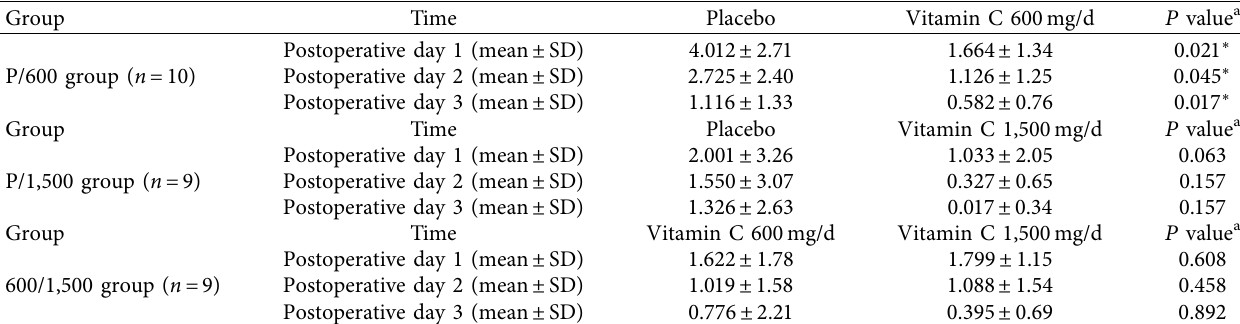
Table 4: Pain scores assessed by VAS (in